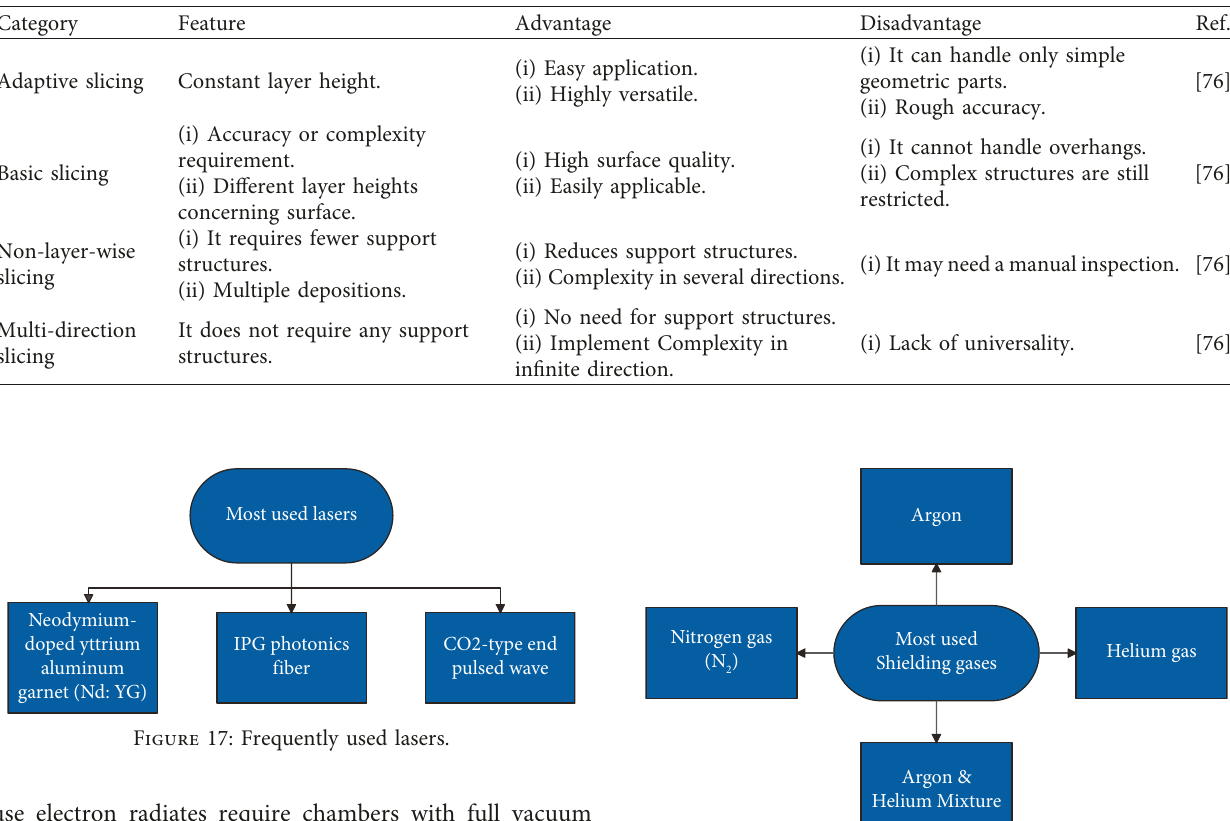
Table 7: Types of slicing methods (advantages and